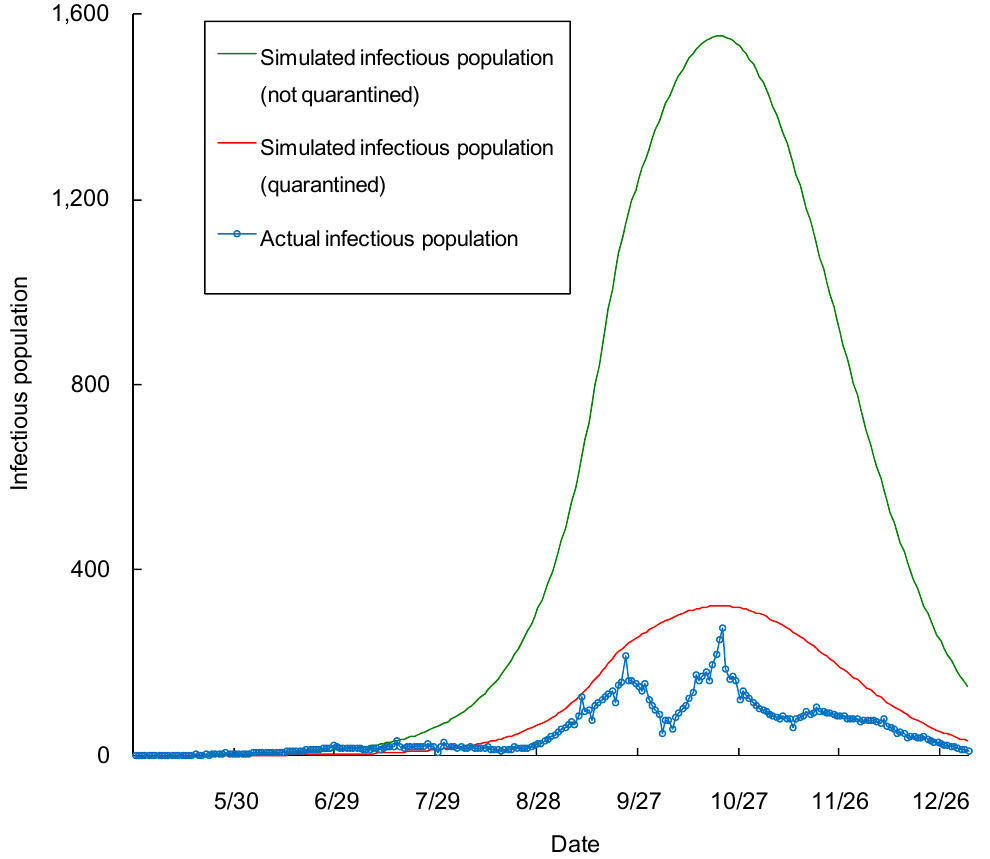
Figure 2. The simulated infectious population of the 2009 H1N1 pandemic in Beijing from 16 May to 31 December, 2009 for the two scenarios, quarantined (red line) and not quarantined (green line) (based on the SEIR model), and the confirmed number of infectious population (blue